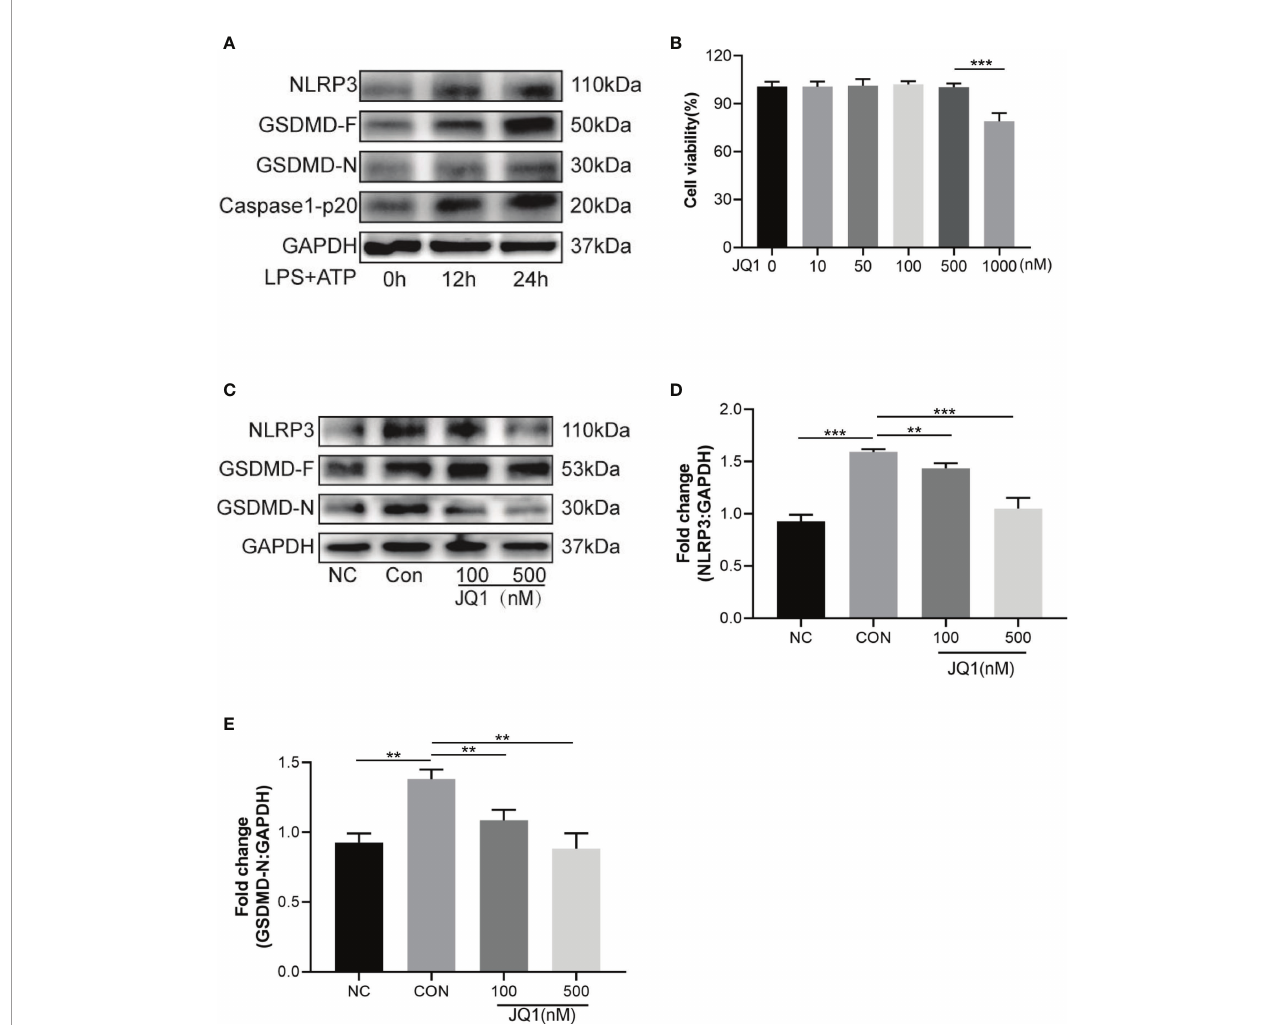
FIGURE 5 | The BRD4 inhibitor JQ1 attenuates neuronal pyroptosis in vitro . (A) Pyroptosis-related proteins were tested by western blot in HT22 cells stimulated with LPS (1 m g/mL) for 12h, 24h and ATP (5 mM) for 30 min. (B) Viability of HT22 cells with different concentrations of JQ1, n = 3 per group. (C) Western blot analysis of pyroptosis-related proteins expression in HT22 cells treated by LPS (1 m g/mL) for 24h and ATP (5 mM) for 30 min with or without different concentrations of JQ1. (D, E) Semiquantitative analysis of NLRP3 and GSDMD-N. Data are presented as mean ± standard deviation (SD) of three independent experiments. (**P < 0.01, ***P <